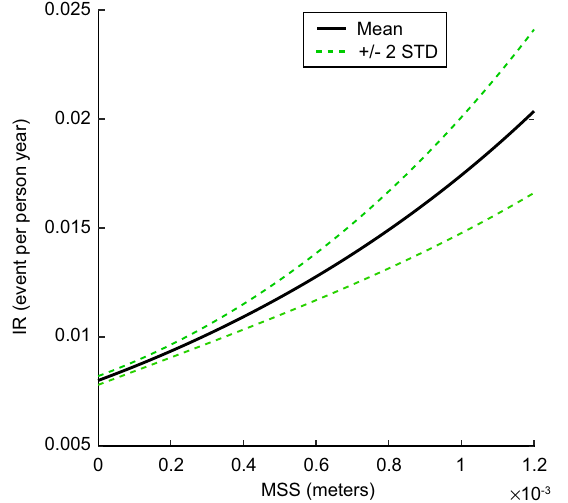
Fig. 8 Relationship of IR to MSS as determined via Poisson regression for rates. The largest MSS for a complete pre- and post- fl ight data set is 1.2 × 10 − 3 m. Rather than extrapolating, we assign the max calculated incidence rate of the regression when the MSS exceeds the limits of the training data. Therefore, to keep the model within the fi t ’ s limits, the incidence rate output is not reported as greater than at 2.07 × 10 − 2 person-years. All IRR are calculated by dividing the discrete, predicted, IR values by the appropriate reference population predicted IR mean value. The parameter values for the resultant curve of the regression are A 8.0027 × 10 − 3 person-years, and B 7.7804 ×10 2